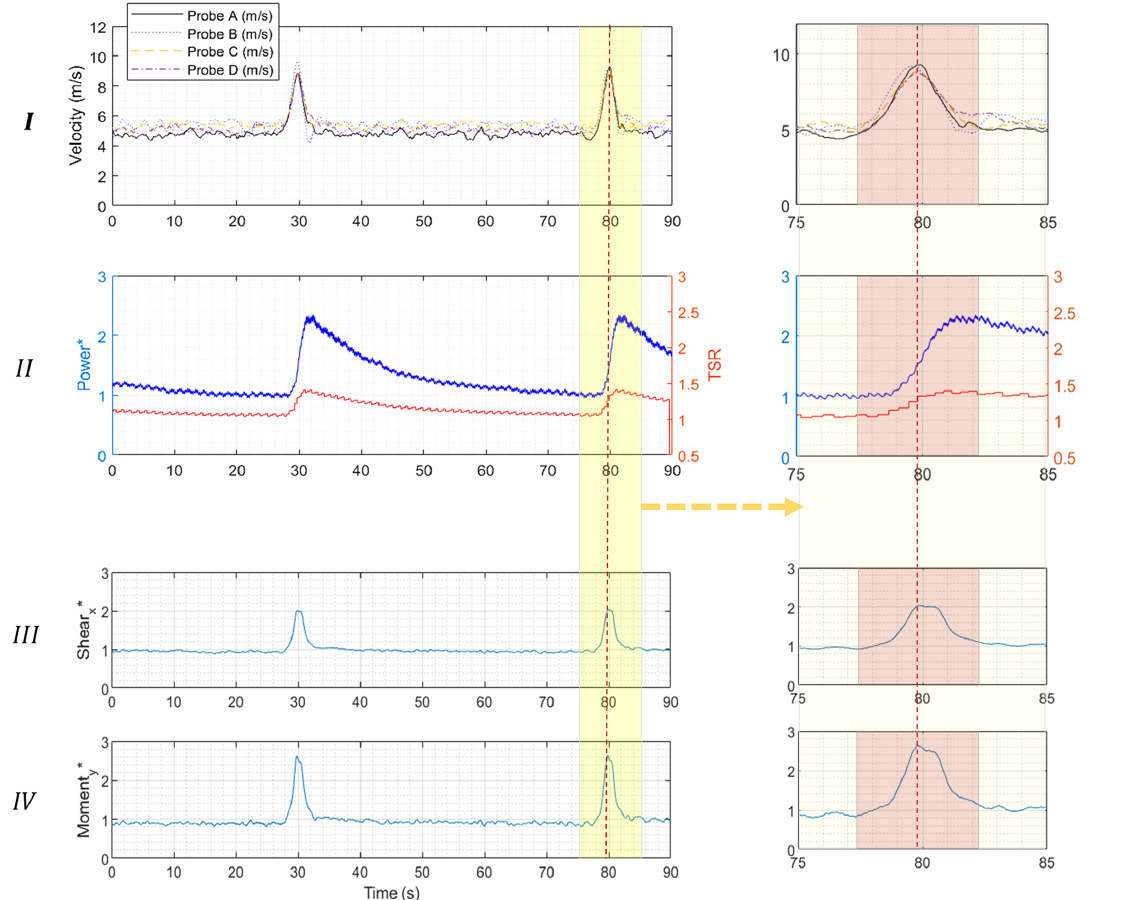
Figure 7. The time history of the results from all the probes in EOG using IGVs: window I shows the wind velocities from four cobra probes, window II shows power performance of the turbine, and windows III and IV show the X shear and Y moment at the tower base. The starred axis indexes are normalized by their corresponding value from uniform case B. The 10s window around the extreme events has been magnified and replotted at the right side with a red 5s window highlighting the theoretical duration of the extreme event and the red dashed line assumed as the centre of the events which passes through the velocity